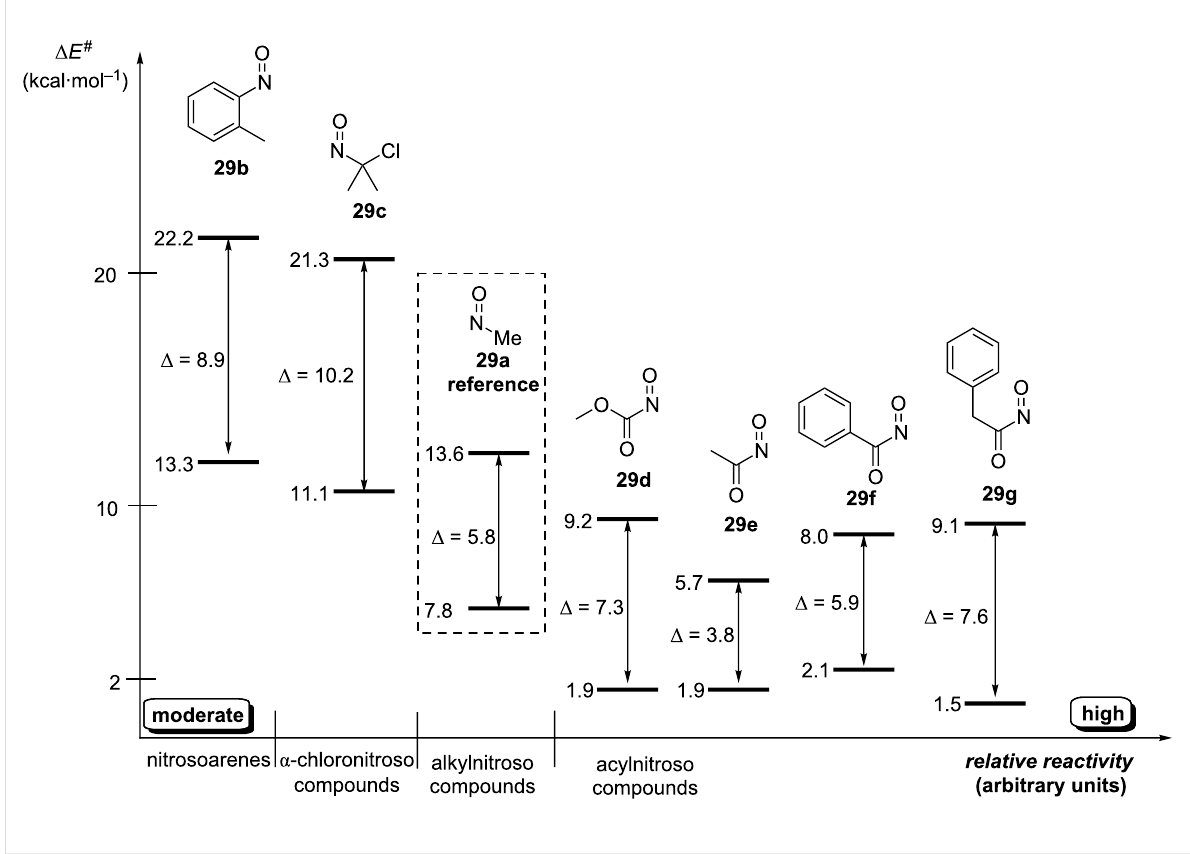
Figure 3: Relative reactivity ( Δ E # ) and regioselectivity ( Δ ) for hetero-Diels–Alder of 28 and nitroso dienophiles 29a–g . Arrows indicate the Δ E # be- tween two